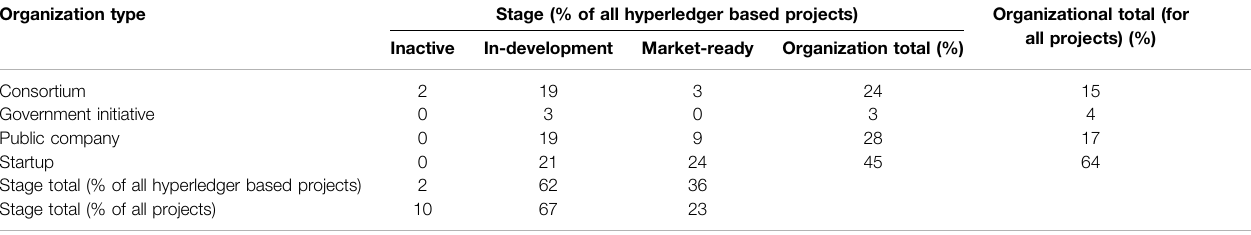
Organization type